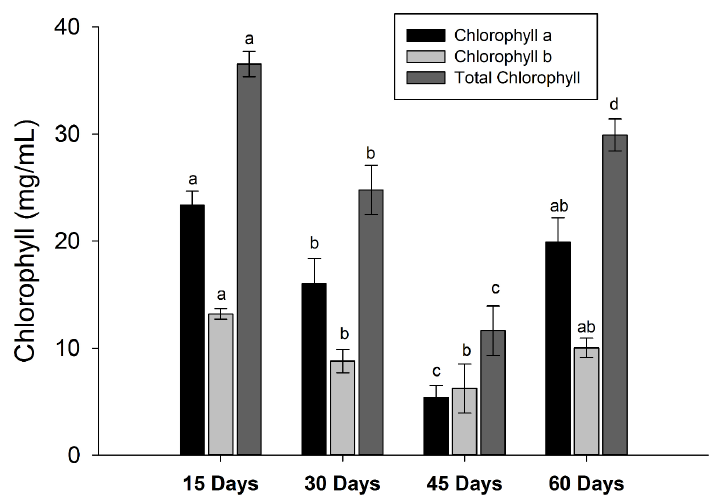
Figure 4. Changes in the pigment contents of the apricot leaves during maturation. Different letters (a–d) in each column represent significant differences at p < 0.01 (Tukey’s test).